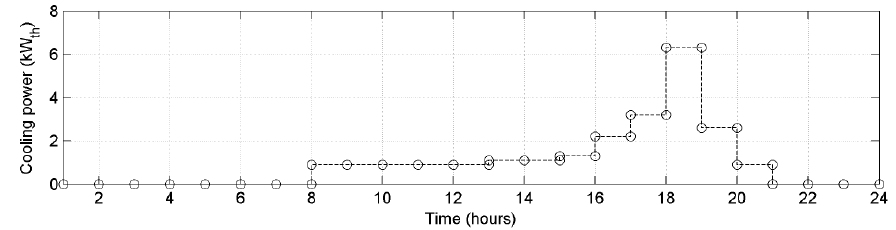
Figure 5. Daily cooling power profile from DC (for the single building).